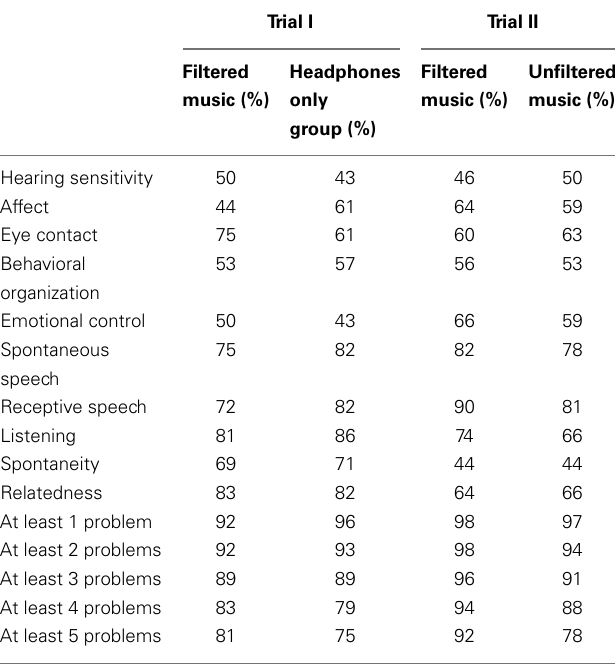
Table 3 | Distribution of initial behavioral problems (%) within each trial.